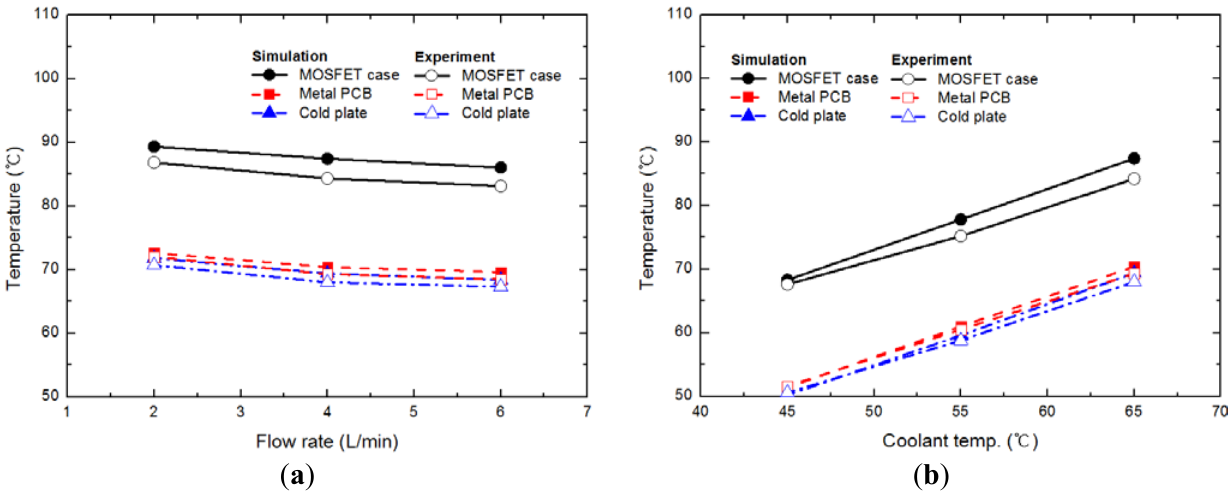
Figure 13. Temperature variations with respect to different parameters: ( a ) variation in temperature with respect to coolant flow rate; and ( b ) variation in temperature with respect to coolant temperature.